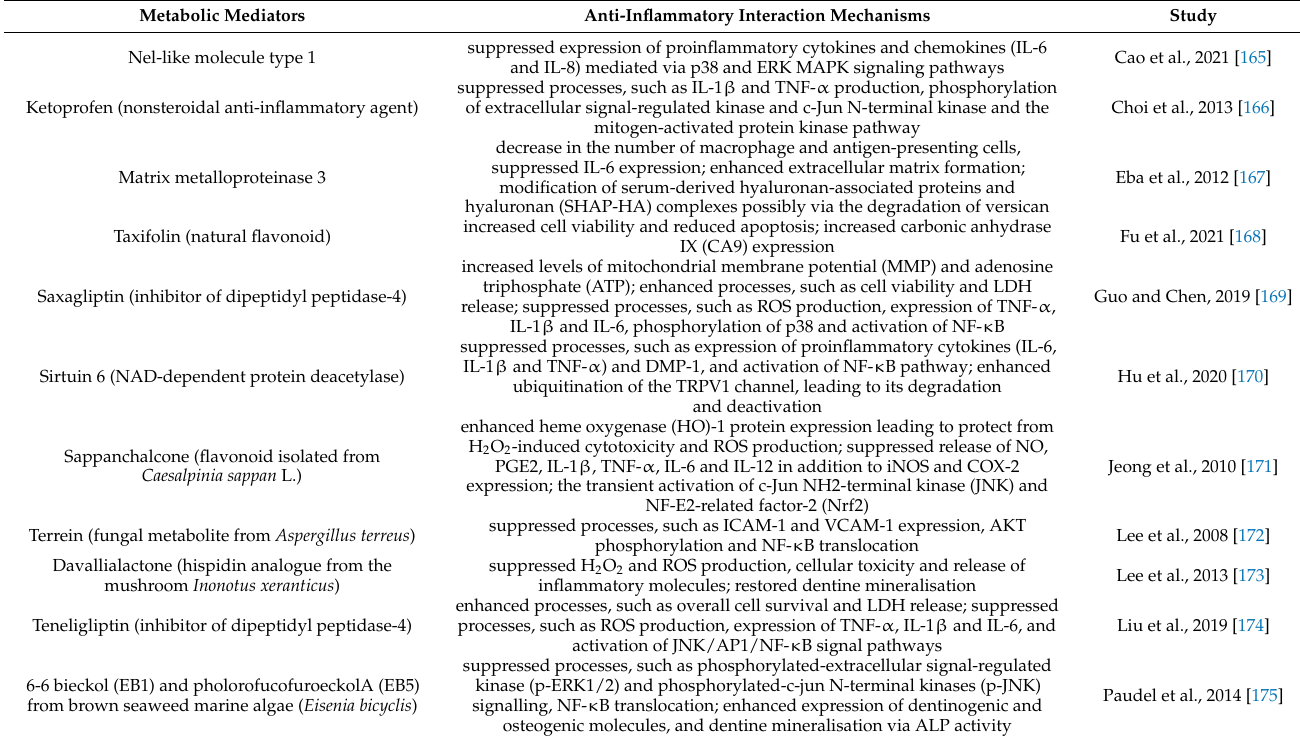
Table 2. Selected potential metabolic mediators with anti-inflammatory interaction against the inflamed pulp